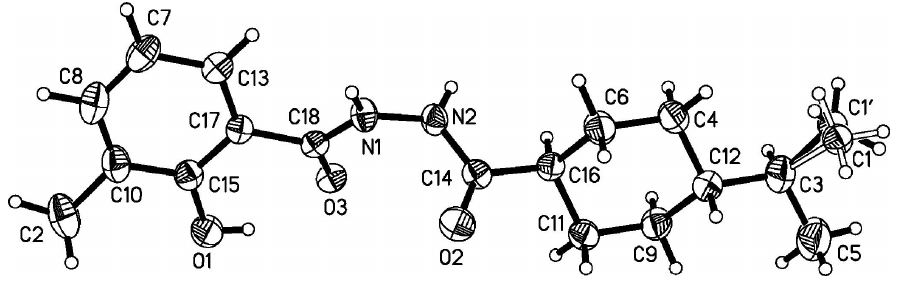
Figure 1 The structure of (I), showing 30% probability displacement ellipsoids and the atom-numbering scheme. [symmetry code: (i) – X , 0.5+Y, 0.5- Z ].